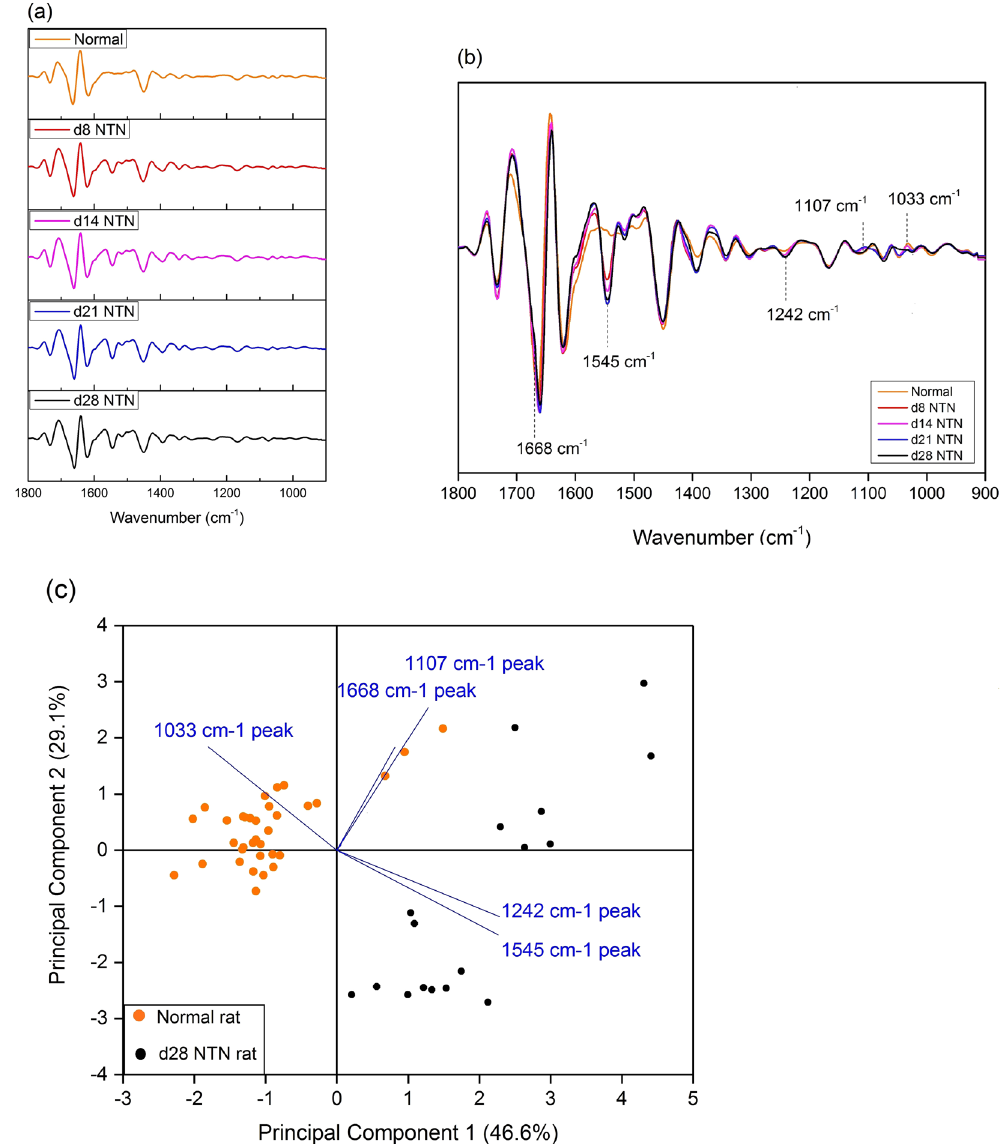
Figure 3. Five features of interest identified in experimental glomerulonephritis. ( a ) The average normalized second derivative FTIR spectra of urine obtained from normal WKY rats and different stages of NTN rats. ( b ) Peaks of interest (1668 cm − 1 , 1545 cm − 1 , 1242 cm − 1 , 1107 cm − 1 , and 1033 cm − 1 ) potentially relevant to renal inflammation and/or fibrosis. ( c ) The PCA bioplot displays the correlations between the five spectral markers and individual urine sample of normal rats (n = 34) and d28 NTN rats (n = 18, there was one outlier excluded from this group). PC1 and PC2 explained 75.7% of total